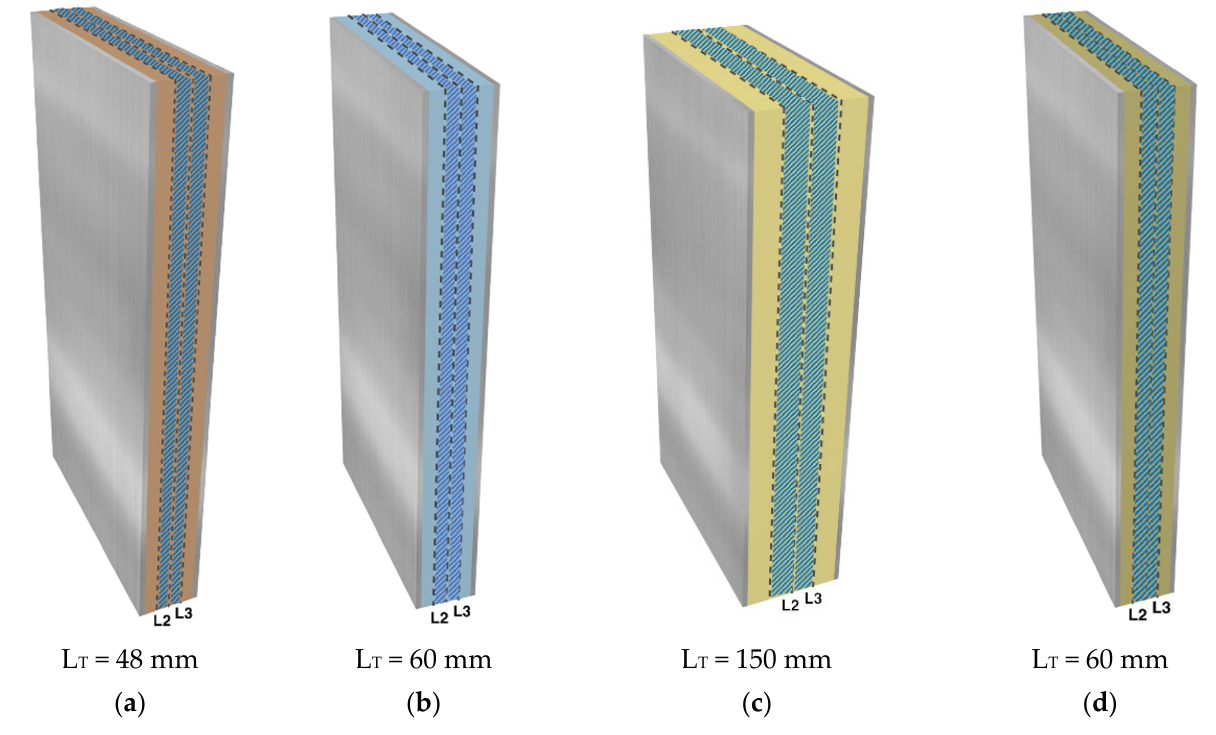
Figure 6. Schematic representation of the panels: ( a ) BAL panel; ( b ) PET panel; ( c ) PUR panel; ( d ) MW panel.